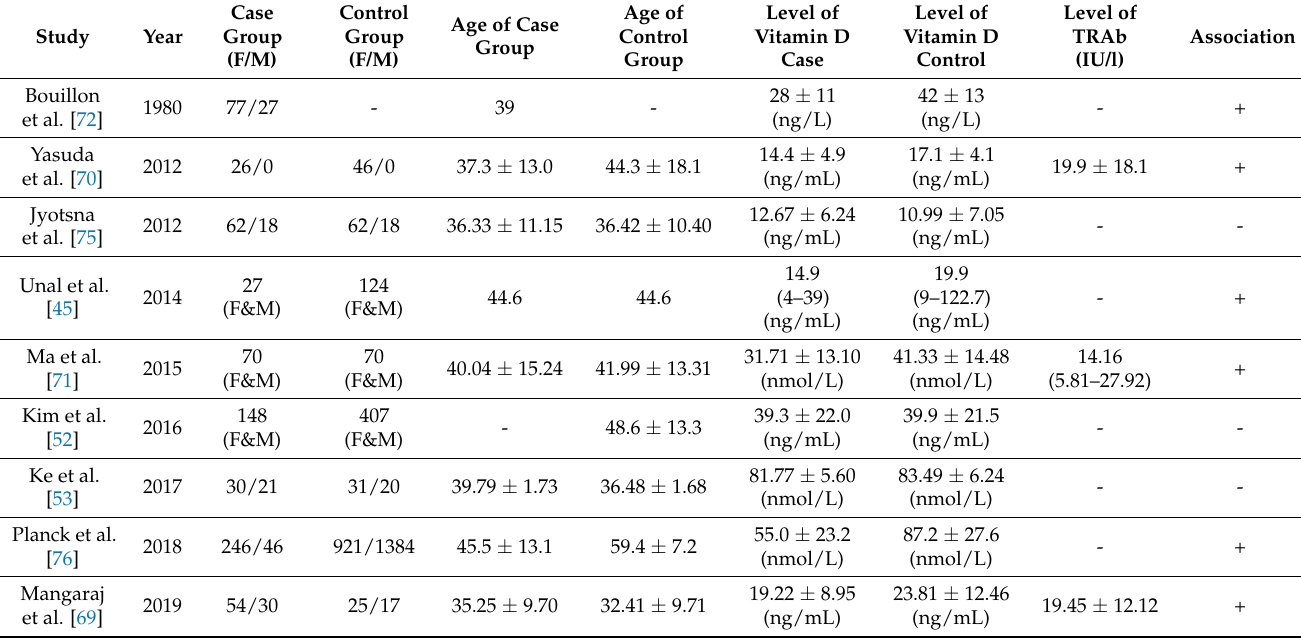
Table 1. Relationship between Graves’ disease and level of vitamin